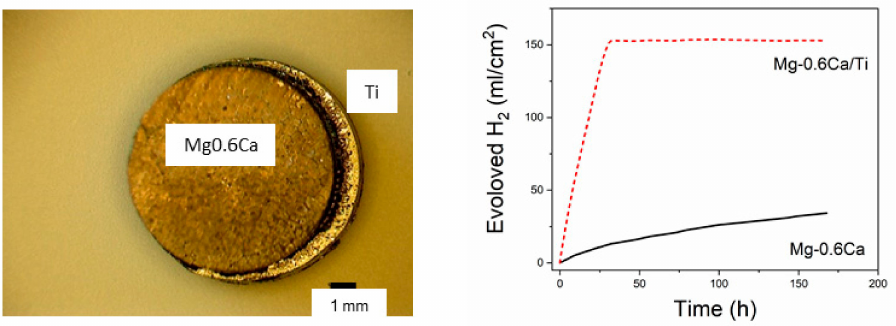
Figure 2. Photo of Mg-0.6Ca and Ti plates after heat treatment at 640 ◦ C for 8 h ( left ) and the evaluation of H 2 for Mg-0.6Ca/Ti couple in saline solutions (0.9 wt.% NaCl) and, in comparison, Mg-0.6Ca alone ( right ).